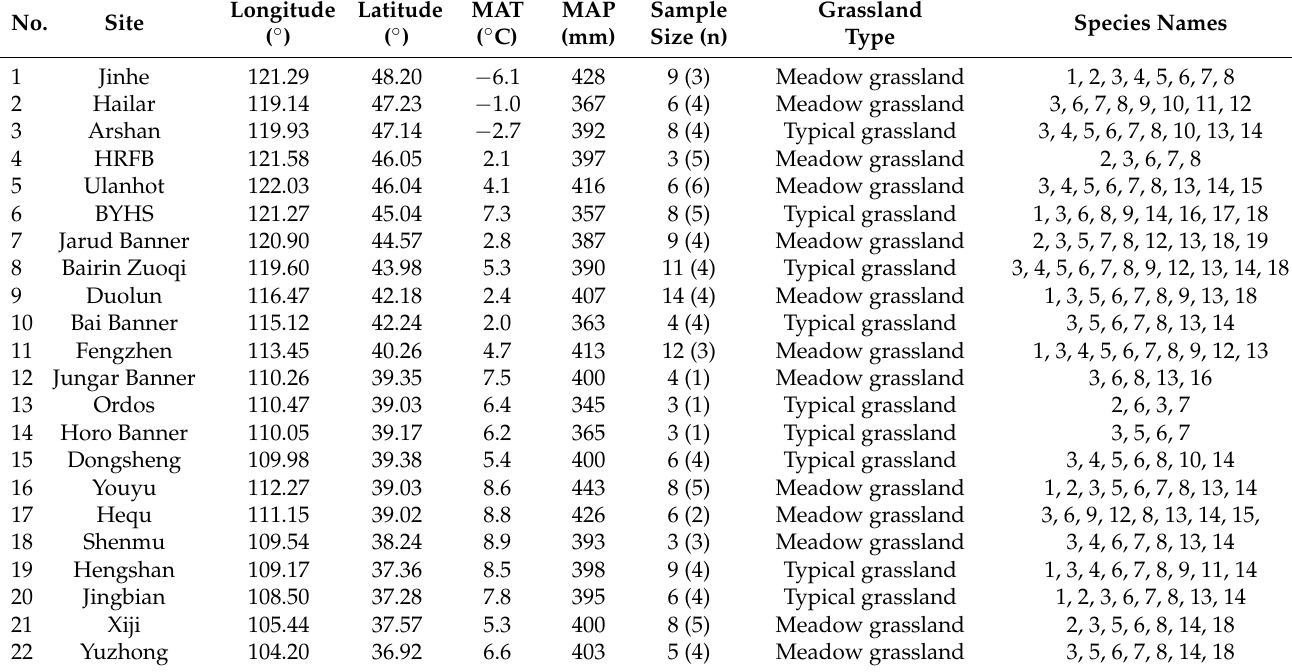
Table 3. The information of the sampling sites and plant species collected at each site.